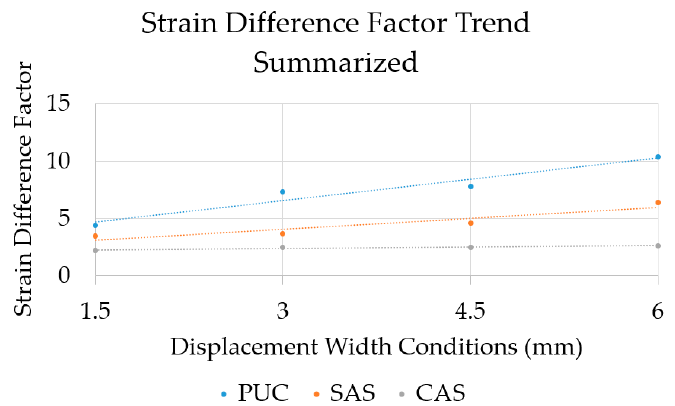
Figure 13. Strain concentration ratio linear regression analysis in accordance with movement